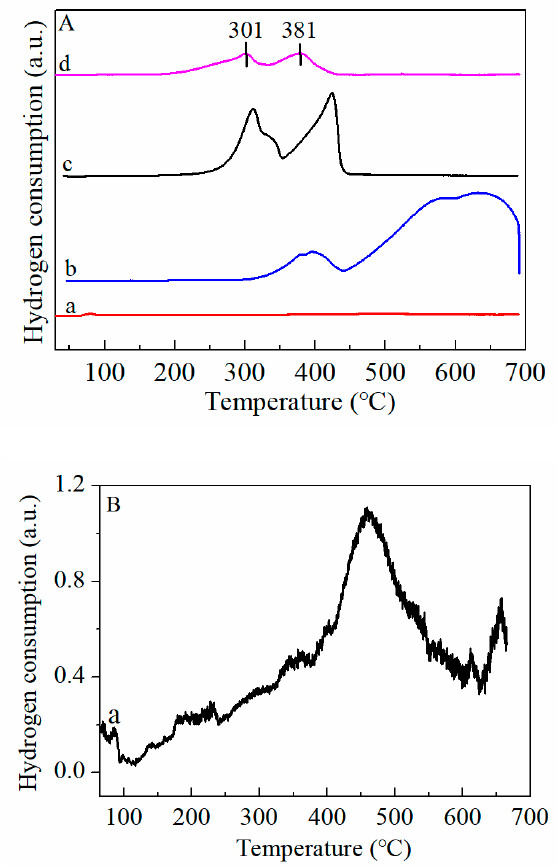
Figure 4. ( A ) H 2 - TPR profiles of (a) CeO 2 , (b) Fe 3 O 4 , (c) MnO 2 and (d) MnO 2 -CeO 2 , ( B ) Enlarged H 2 - TPR profiles of (a) CeO 2 . H 2 - TPR profiles of (a) CeO 2